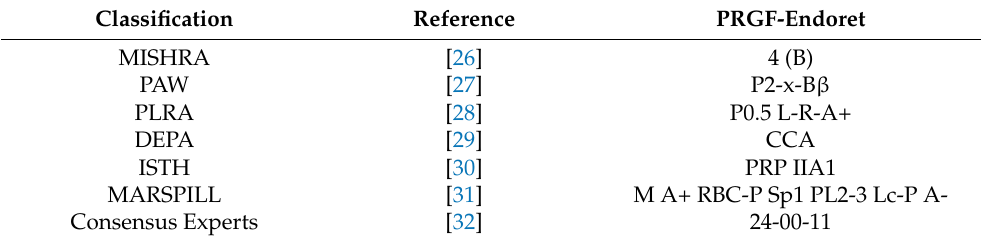
Table 1. PRGF-Endoret system (BTI Biotechnology Institute) classification.